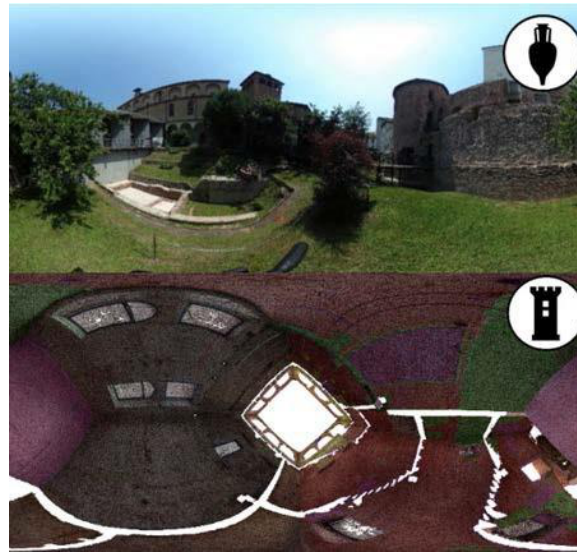
masonry elevation the structures corresponding to each phases of its life.